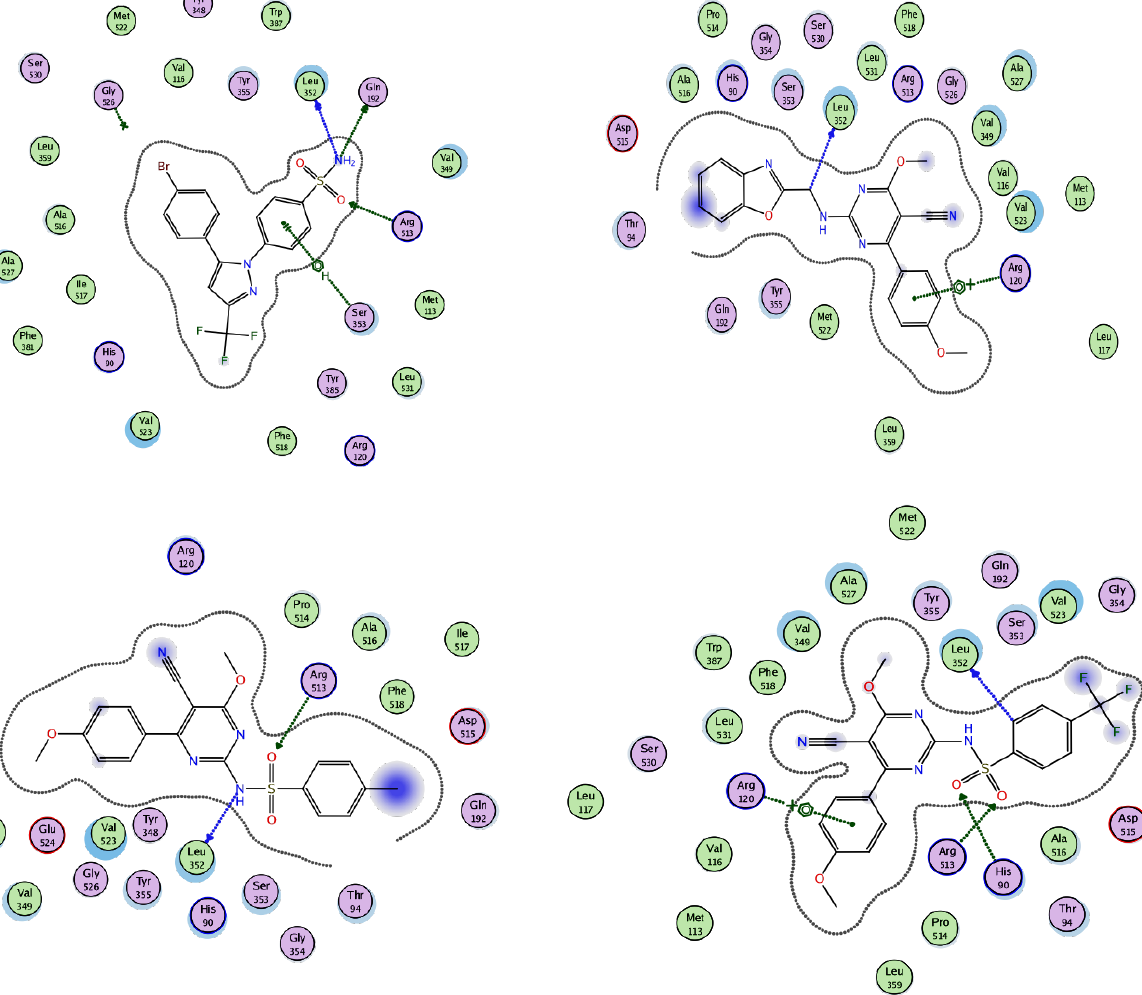
Figure 6. 2D interactions of the co-crystallized ligand Celecoxib (upper left panel), 3b (upper right panel), 5b (lower left panel), and 5d (lower right panel) with the active site of cyclooxygenase 2 (PDB ID code: 1CX2).